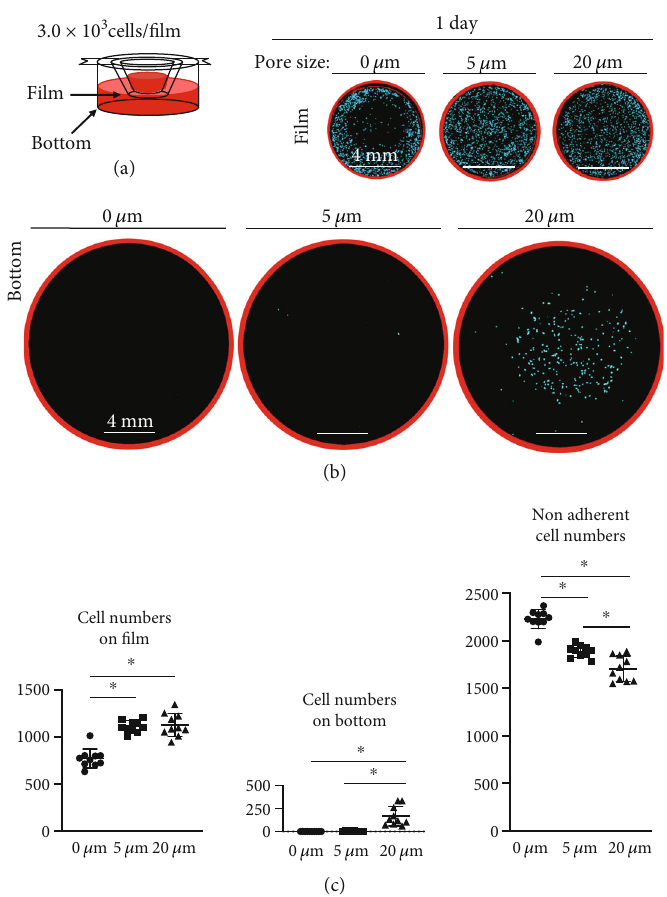
Figure 3: Analysis of numbers of synovial MSCs remaining in and passing through PLA fi lms. (a) Experimental setting. (b) Images of MSCs remaining on PLA fi lms and MSCs passing to the bottoms of the plates. DiI-stained cells were observed from above and image processed and are shown in blue. (c) Quantitative evaluation of cell numbers on the fi lms, on the bottoms of the dishes, and nonadherent cells. Means and standard deviations are shown ( n = 10 ). ∗ P < 0 : 05 . P values were determined by one-way ANOVA with Tukey ’ s multiple comparisons